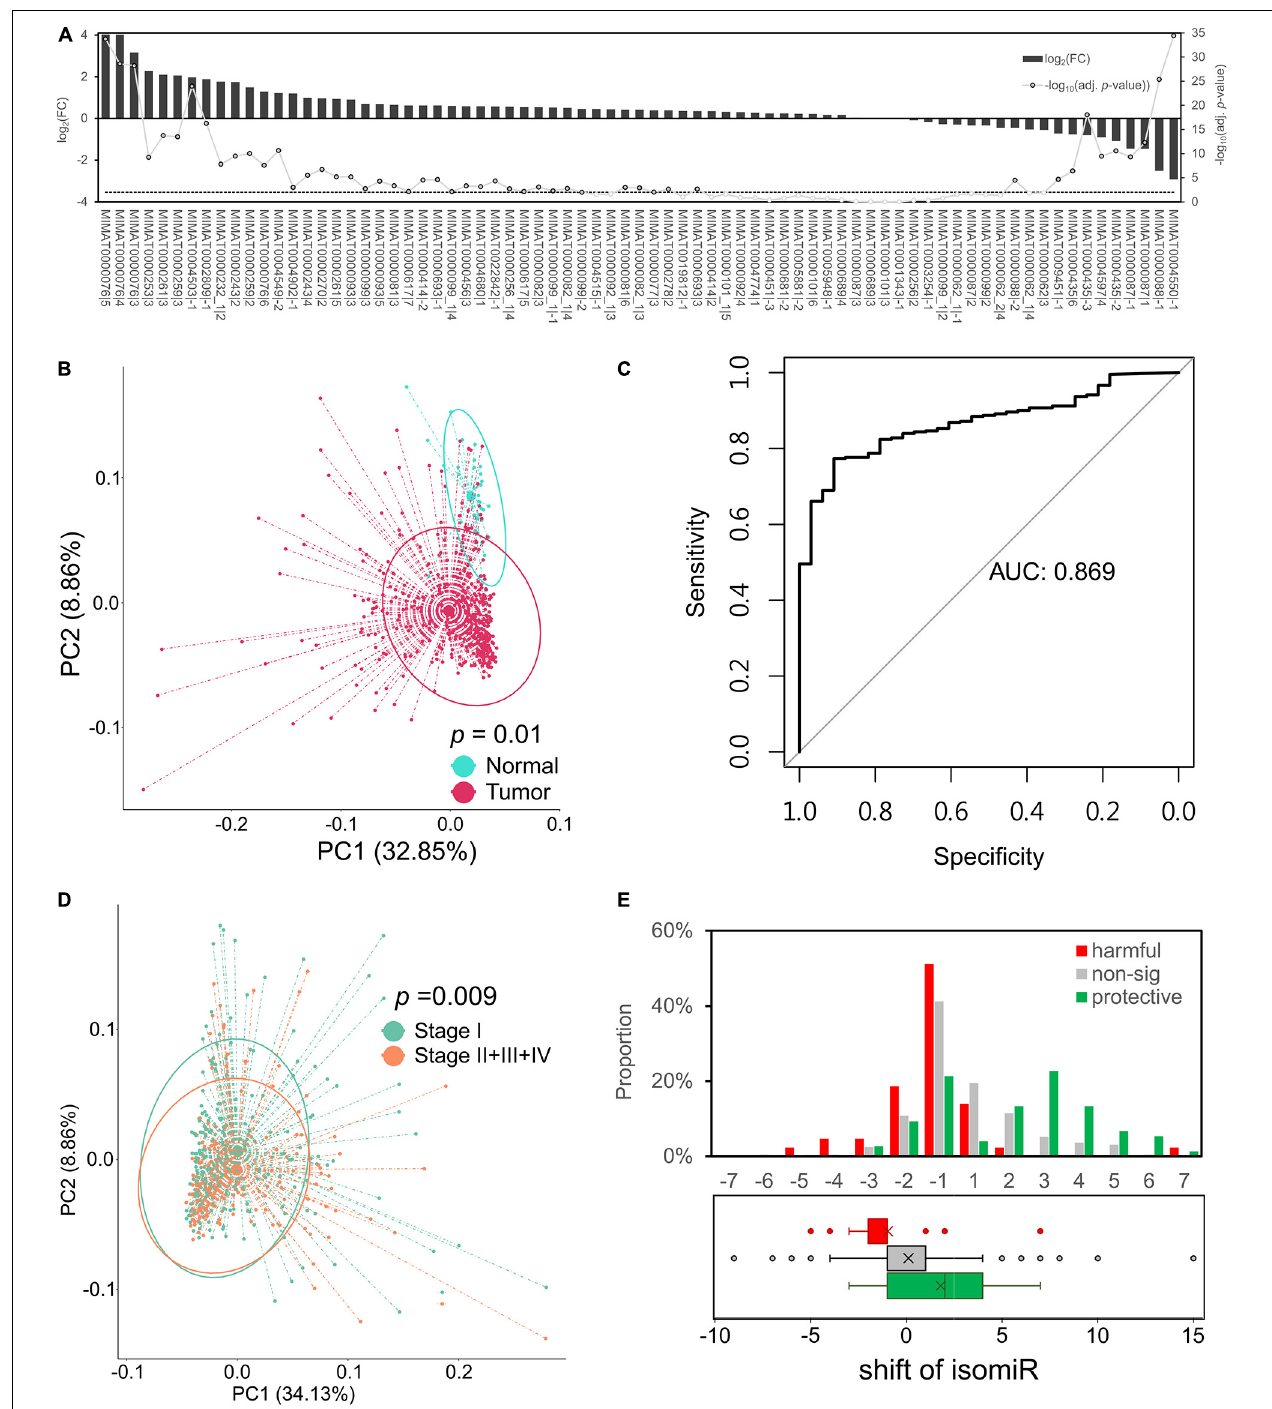
FIGURE 2 | Protective isomiRs are capable to separate LUAD samples. (A) The differential expression pattern of the 75 identified protective isomiRs. The bars (related to the left y -axis) show the differential expression level of the corresponding isomiR at the x -axis; the line chart indicates the significance level (related to the right y -axis). The dashed line marks the significance level with p -value < 0.01. (B) Principal component analysis (PCA) using the 75 protective isomiRs classifies tumor and normal samples. The p -value is derived from permutational analysis of variance (PERMANOVA). (C) The ROC curve of 75 protective isomiRs by its log-transformed PC1 and PC2 to predict the total tumor samples. (D) PCA using the 75 protective isomiRs classifies patients with early and late stage tumors. The p -value is derived by PERMANOVA. (E) The shift distribution of isomiRs. The upper panel shows the shift distribution of protective, harmful, and insignificant isomiRs. The lower panel displays the tendency of the shift preference of the three categories of isomiRs by a boxplot.